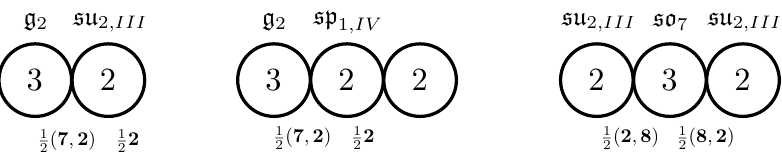
Figure 5 . Gauge algebra and matter content for single-curve NHCs.